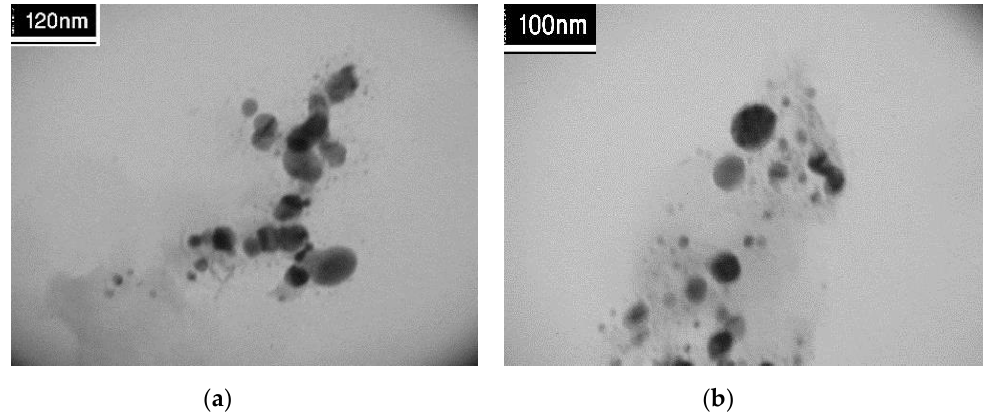
Figure 5. TEM images of Pd/coral reef nanocomposite. ( a ) 120 nm; ( b ) 100 nm.